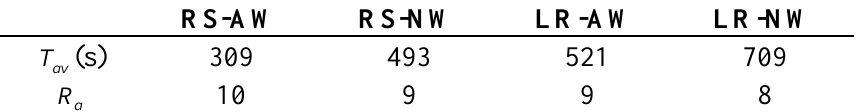
Table 2. Experimental results for plume finding/tracking